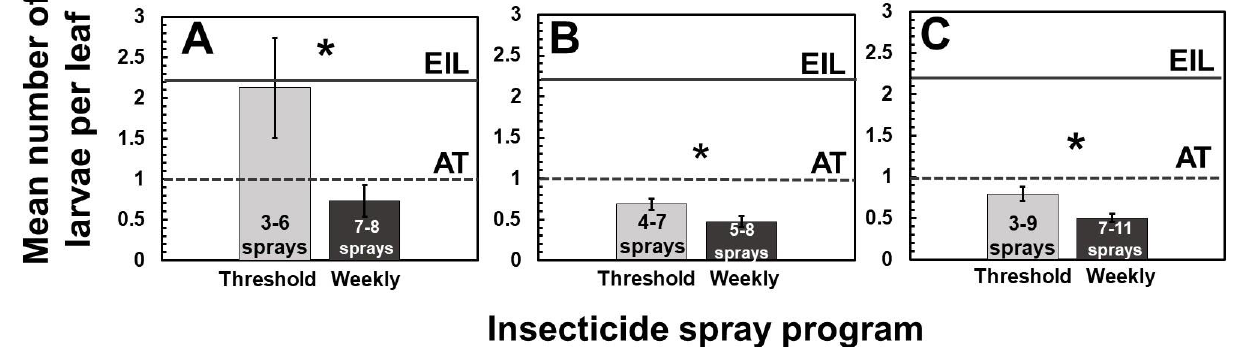
Figure 2. Mean ( ± SEM) number of T. tabaci larvae per leaf over the duration of our sampling in onions treated with insecticides following either an action threshold program or weekly application program in 2019 ( A ), 2020 ( B ), and 2021 ( C ) in New York (USA). Because thrips densities were not significantly affected by fertilizer rate or an interaction between fertilizer rate and insecticide program, data were pooled across all three fertilizer treatments. Asterisks indicate significant differences between spray programs (Tukey’s HSD, p < 0.05). The range in number of sprays applied in each program in each year are denoted within each bar. The economic injury level (EIL) of 2.2 thrips larvae per leaf is denoted by a solid line, and the action threshold (AT) of 1 thrips larva per leaf is denoted by a dotted line.